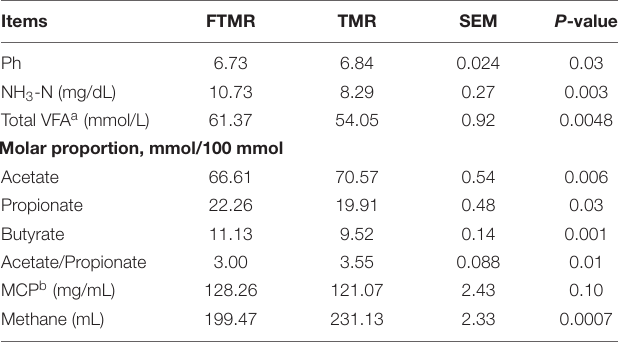
TABLE 5 | In vitro pH, NH 3 -N, MCP, VFA, and methane production of fermented or non-fermented TMR.